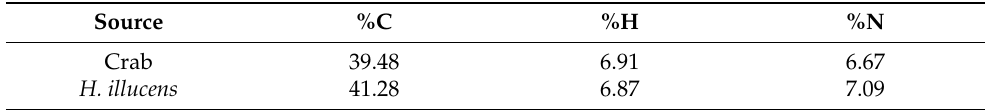
Table 1. Elemental analyses data for depolymerised chitosans obtained from crab (6.78 kDa) and H. illucens (6.86